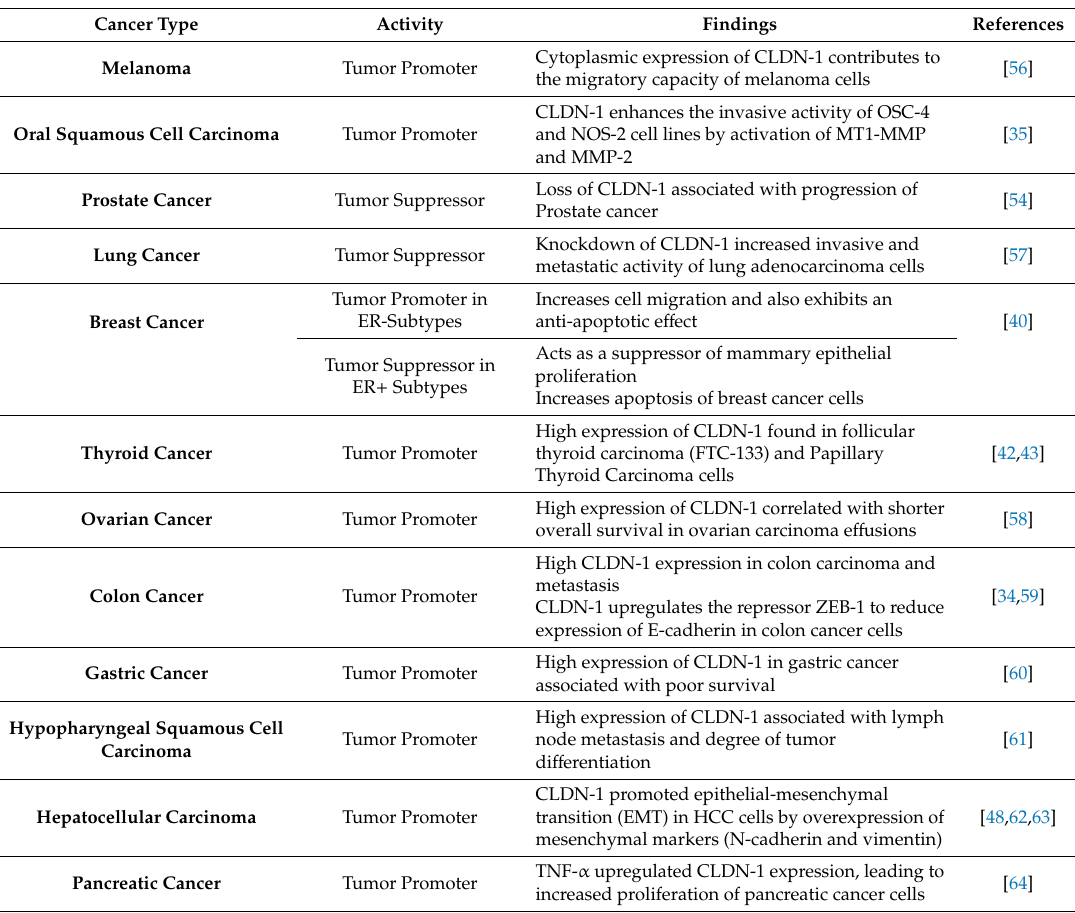
Table 2. Role of CLDN-1 in di ff erent